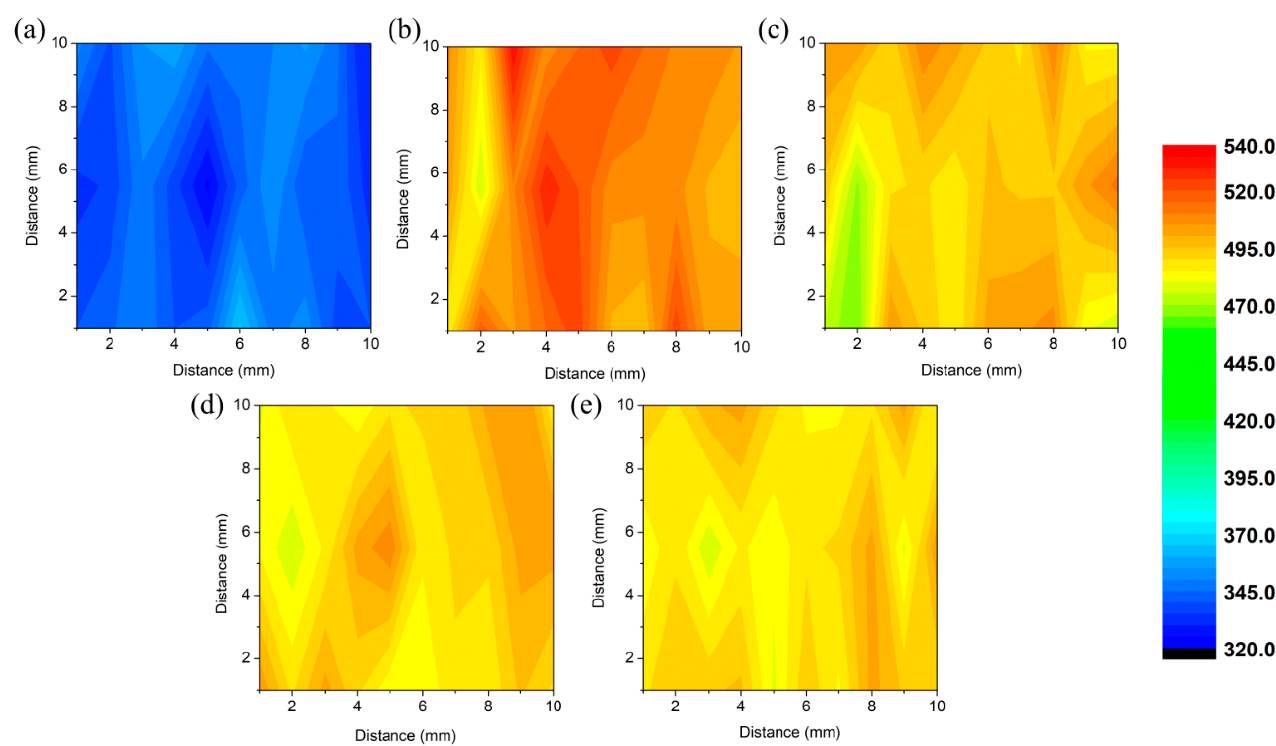
Figure 13. Microhardness maps of IN718 specimens in ( a ) AB, ( b ) HT1, ( c ) HT2, ( d ) HT3, and ( e ) HT4 conditions.